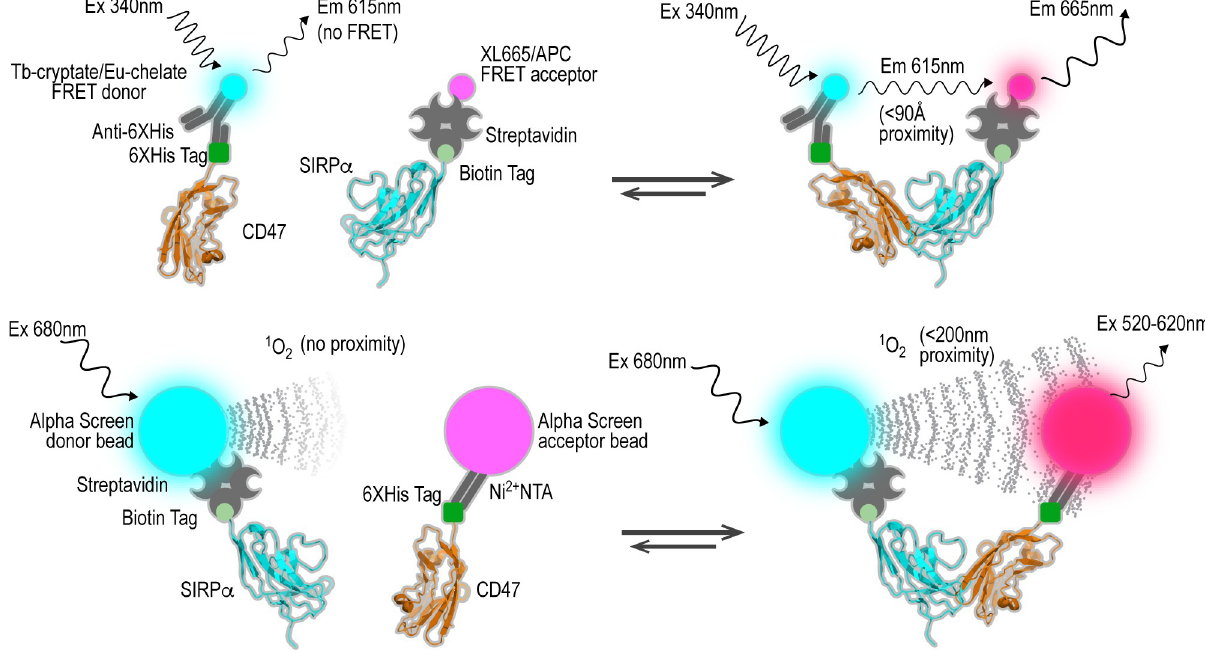
Fig 3. Schematic for qHTS assays. TR-FRET based assays (upper panel) and ALPHAScreen assay (lower panel). CD47 and SIRP α represented as their x-ray crystal structures from PDB 2JJS, chain D and chain B, respectively.